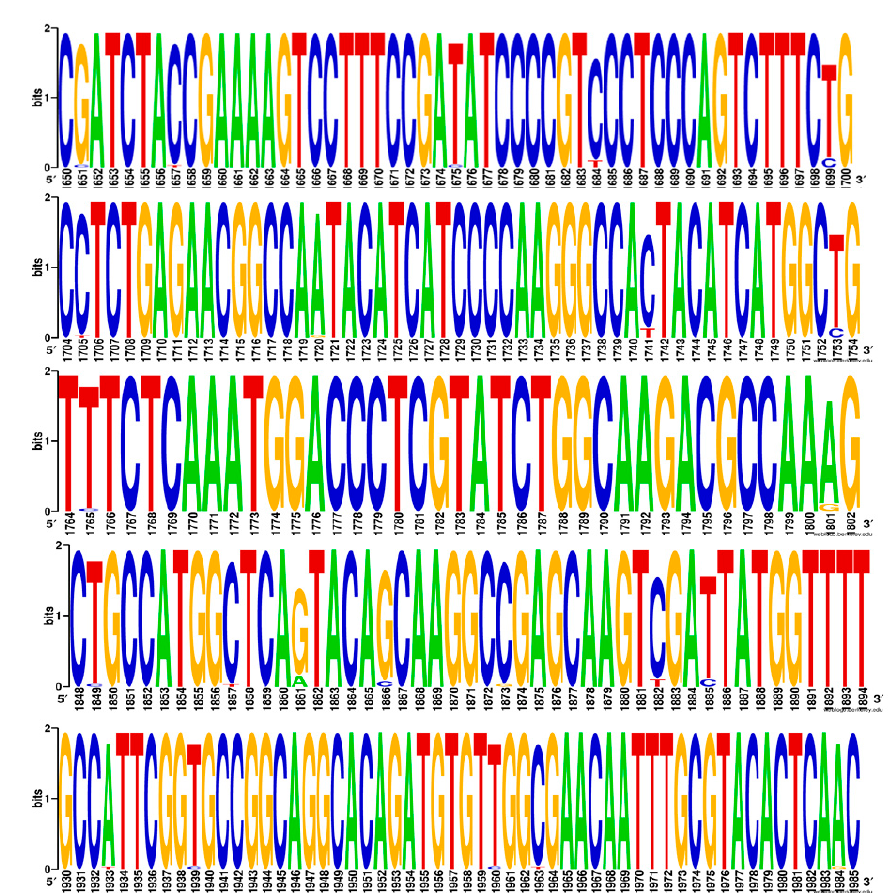
Table 3) resulted in the amino acid changes A457V and S460T. Novel synonymous SNPs found in the C. neoformans clinical isolates that had not been previously reported were also identified. Surprisingly, low fluconazole IC 50 s < 8 μ g/mL were observed in isolates with amino acid changes; and isolates with high fluconazole IC 50s did not contain